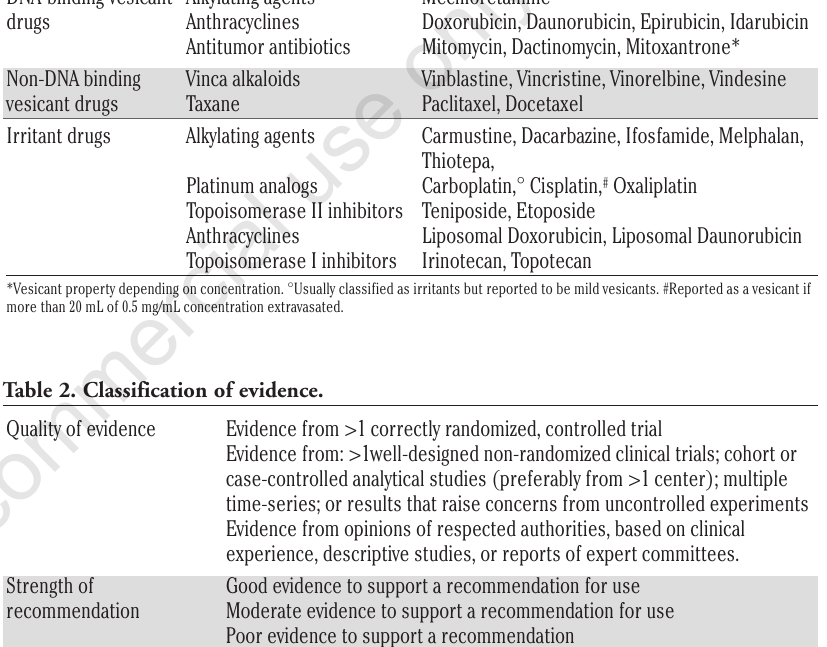
Table 1. Vesicant and irritant chemotherapeutic agents. DNA-binding vesicant Alkylating agents